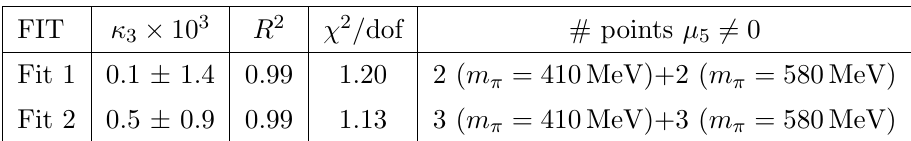
Figure 7 . Fits of (cid:31) top ( (cid:22) 5 ) =(cid:31) top (0) using the ChPT expression (5.52). The lattice points used for the (cid:12)t are those in [23].